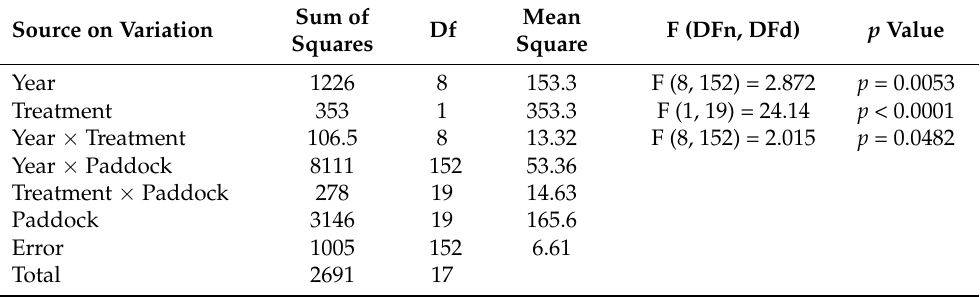
Table A8. Intra-annual Enhanced Vegetation Index (EVI) Variability two-way repeated measure ANOVA of natural grassland and Natural Grasslands overseed with Legumes with Phosphorus fertilization (NG-LP), during 9 years after intensification practice ( n = 20). Source on